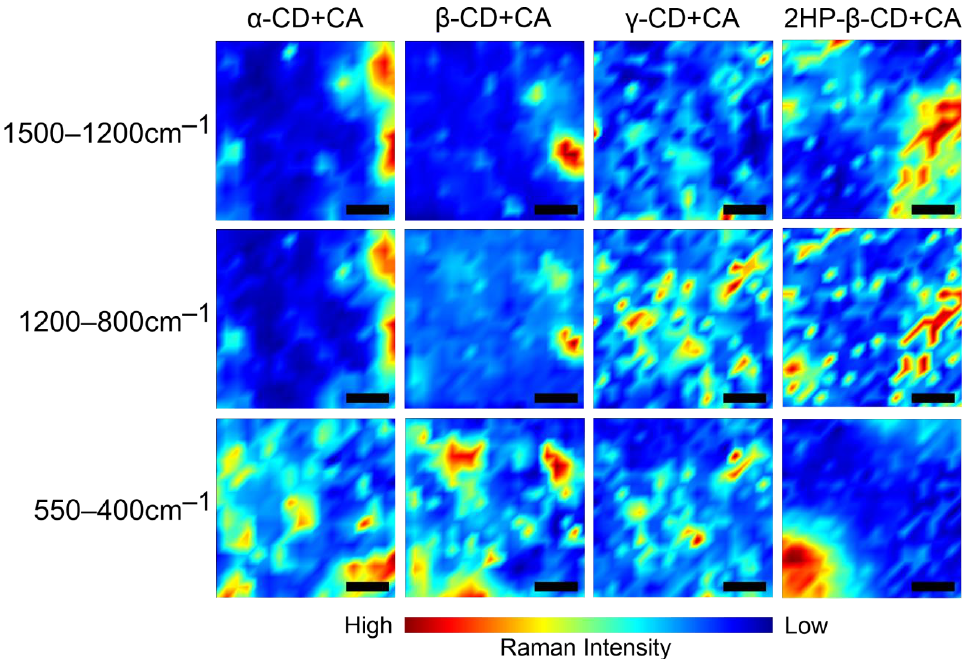
Figure 7. Raman chemical maps of structural moiety distribution in CA–CD complexes. Black scale bar at the bottom of the images corresponds to 20 µm.